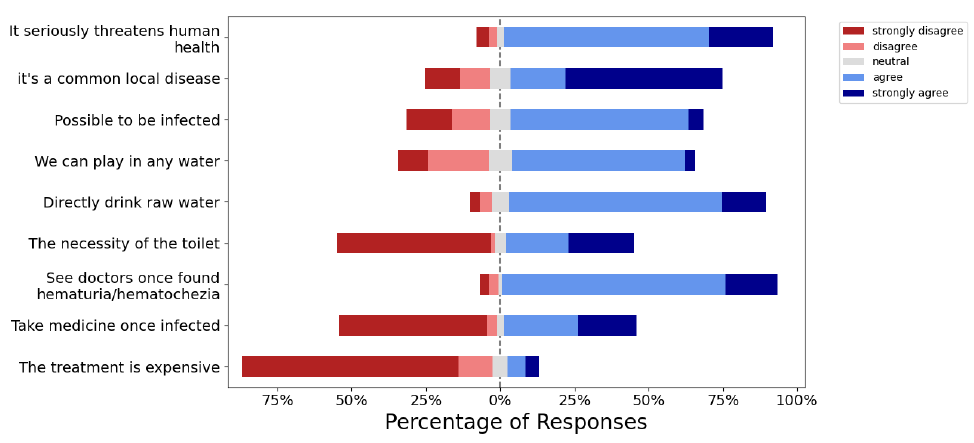
Figure 2. Participants’ attitudes towards schistosomiasis.